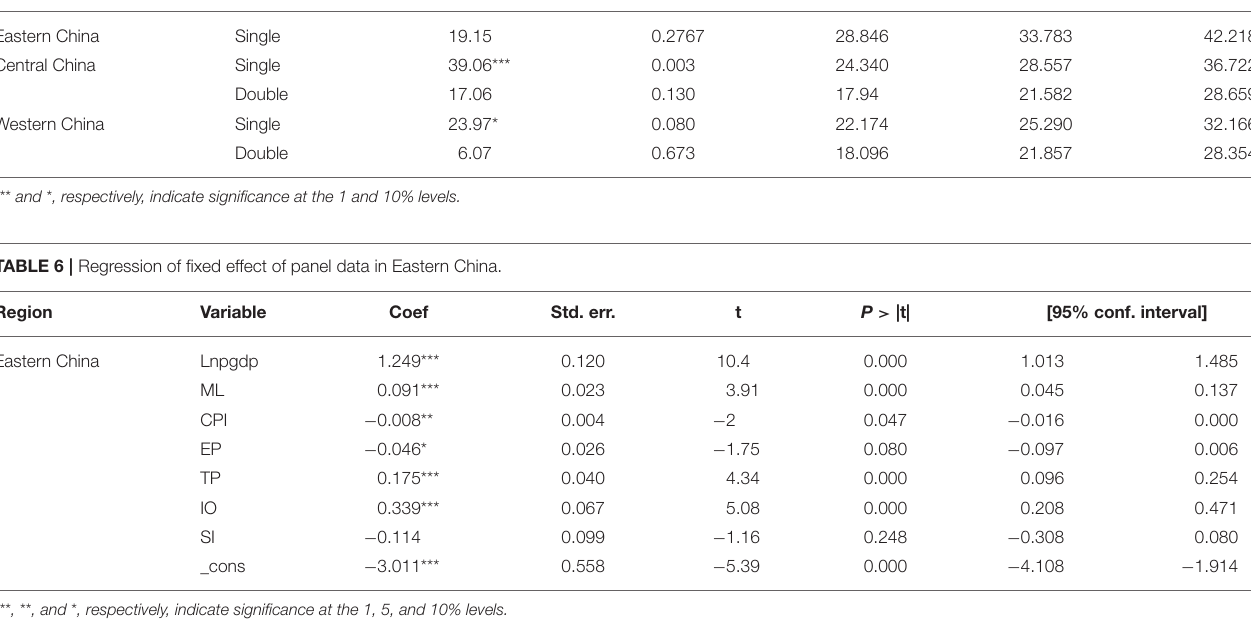
TABLE 5 | Tests for threshold effects between GDP and public health in the subregion. Region